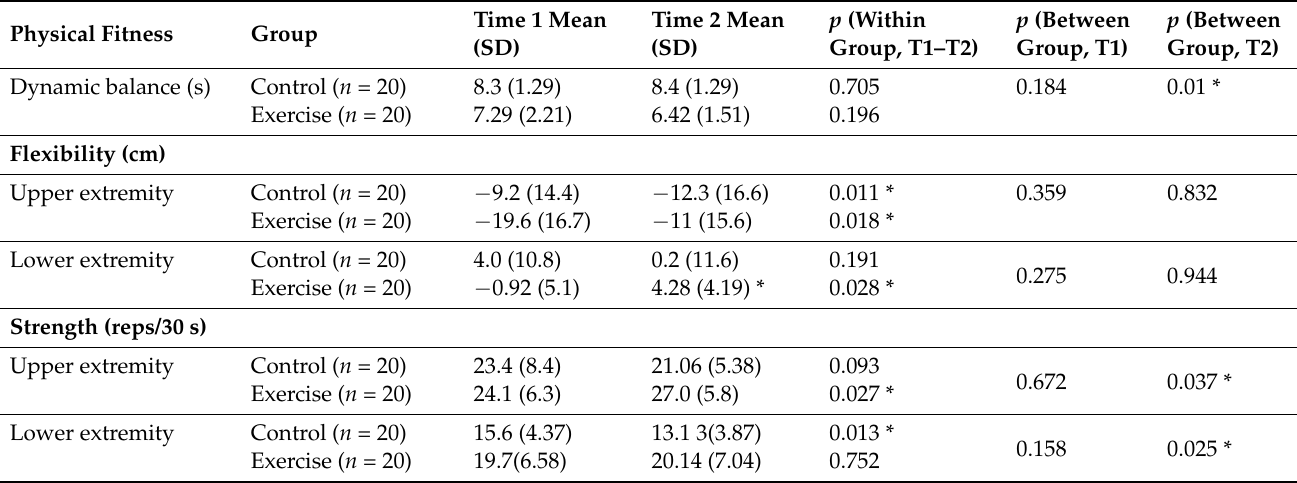
Table 3. Balance, flexibility and muscular strength outcomes between the exercise group and control group at pretest and posttest.